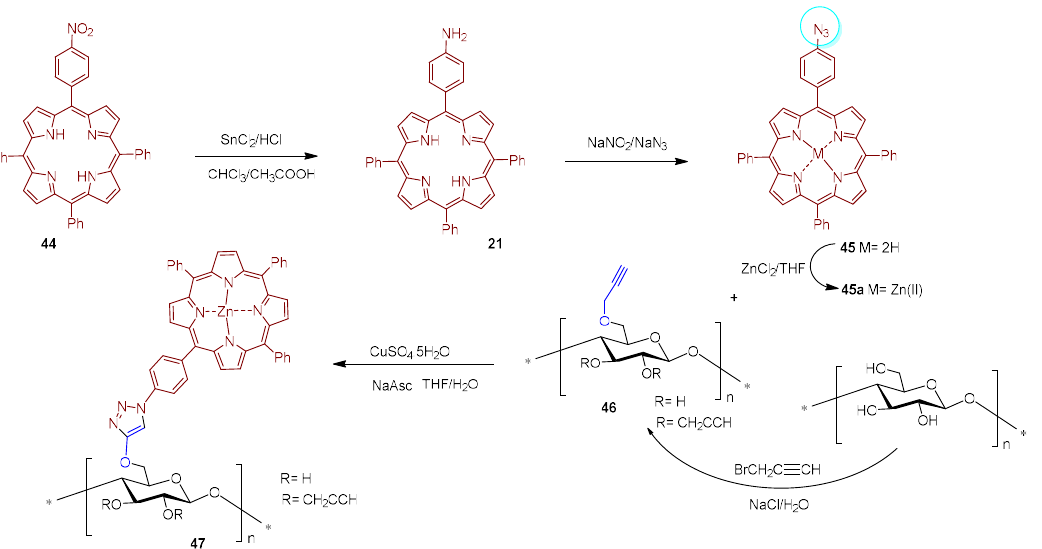
Figure 32. Synthetic route for the preparation of metalloporphyrin 45a and conditions used for its grafting on modified cellulose 46 (adapted from Ref. [130] ).